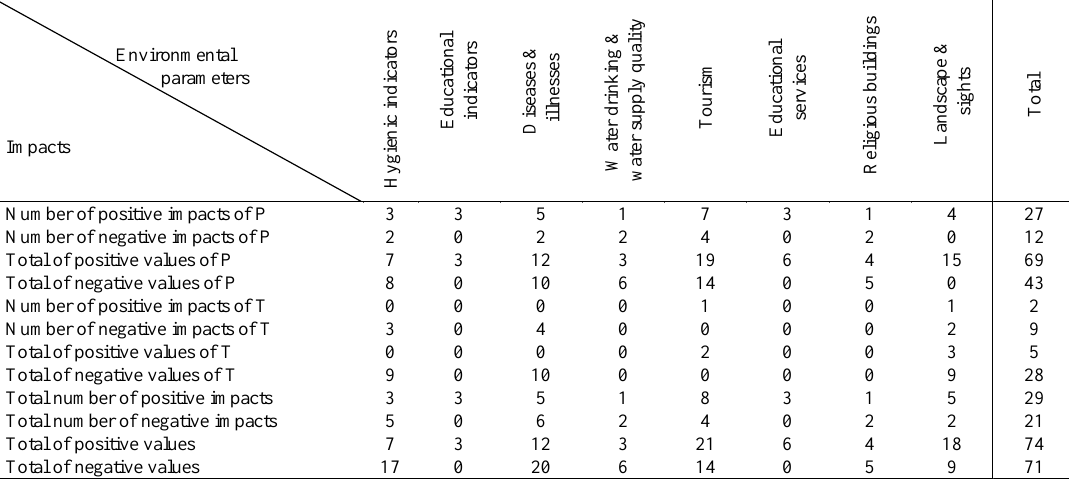
Table 13: Summary of cultural impacts of Kavar irrigation and drainage